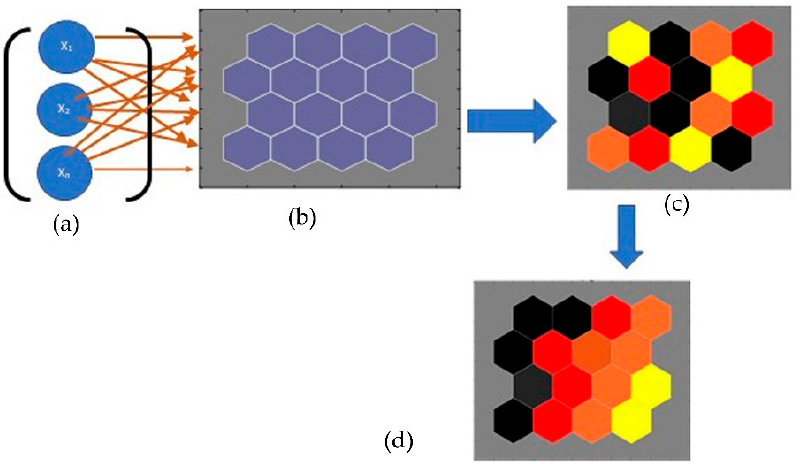
Figure 2. Computing schematic example of a Self-Organizing Map. ( a ) This represents the input data. ( b ) Illustrates data being mapped to the hexagons for the model. ( c ) Illustrates the winning neuron process based on the Euclidian distancing method. ( d ) Final input plane.